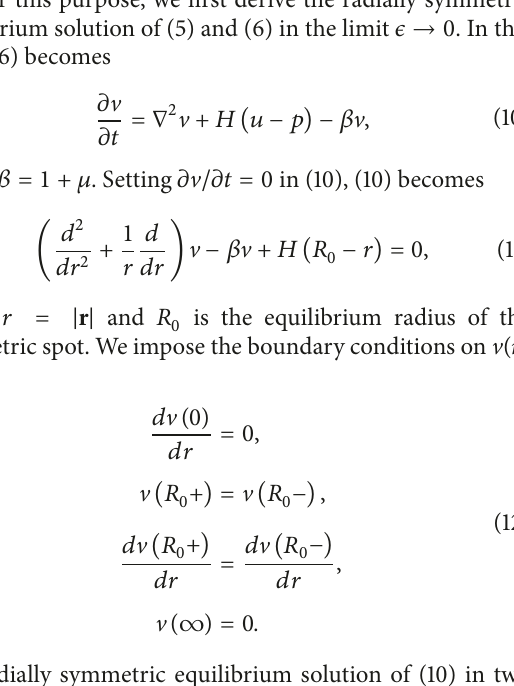
0 with the thickness of 𝑢(| r | = 𝑅 ) = 𝑝 . 𝑢 (| r |, 𝑡) 0 0